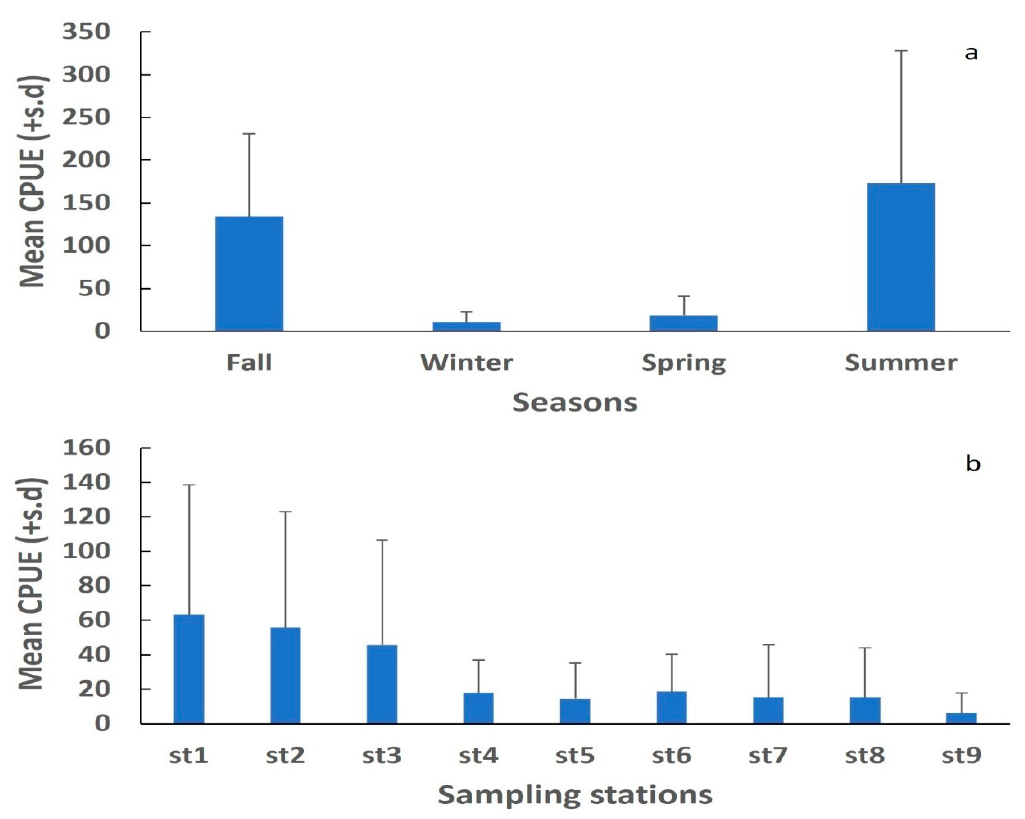
Figure 3. ( a , b ) Mean CPUE ( ± SD) of the blue crab Callinectes sapidus per season (November 2020– October 2021) ( a ) and per sampling station (st. 1–st. 6: lagoon; st. 7–st. 9: coastal area) ( b ) in Monolimni Lagoon and the adjacent coastal area.